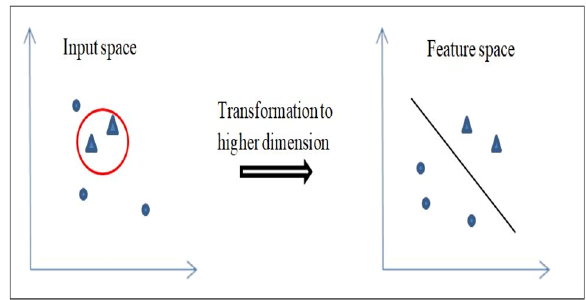
Figure 1. Basic idea of